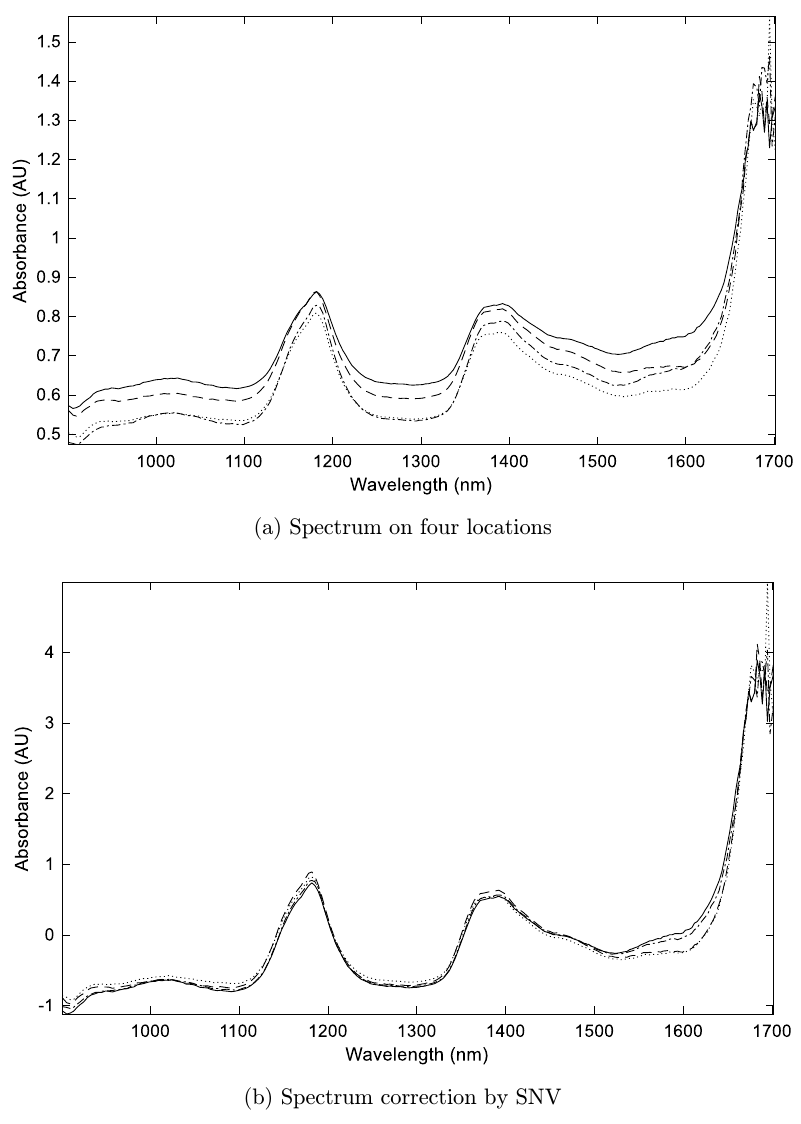
Fig. 3. SNV spectral processing based on di®erent